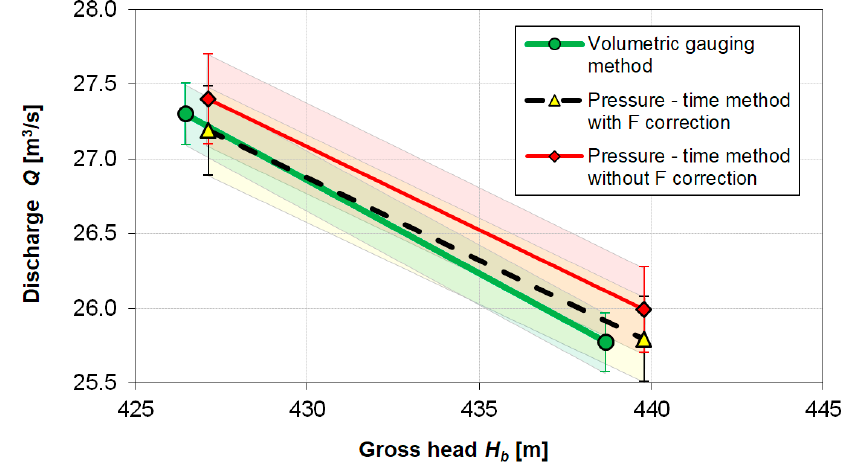
Figure 11. Pump operation mode of the tested hydrounit: Comparison of the discharges measured by the volumetric gauging method and the pressure-time method.